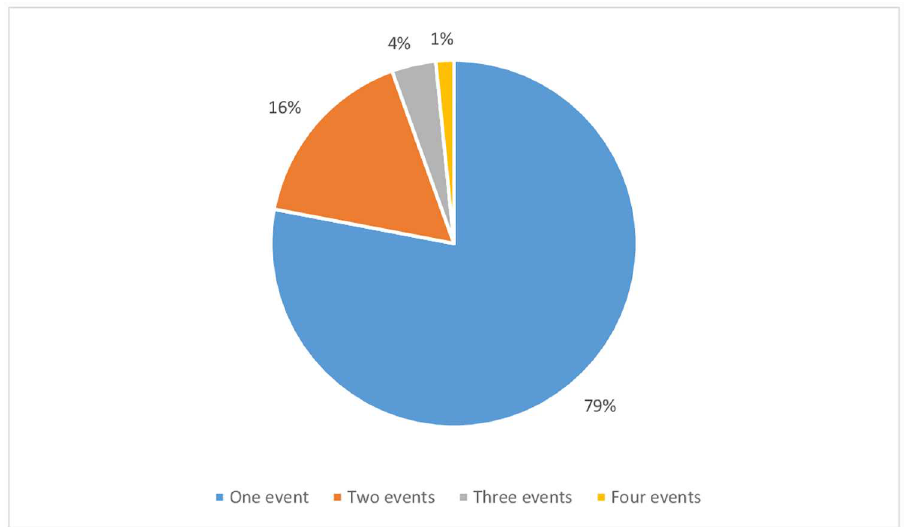
Fig 2. Hyperkalemic events per